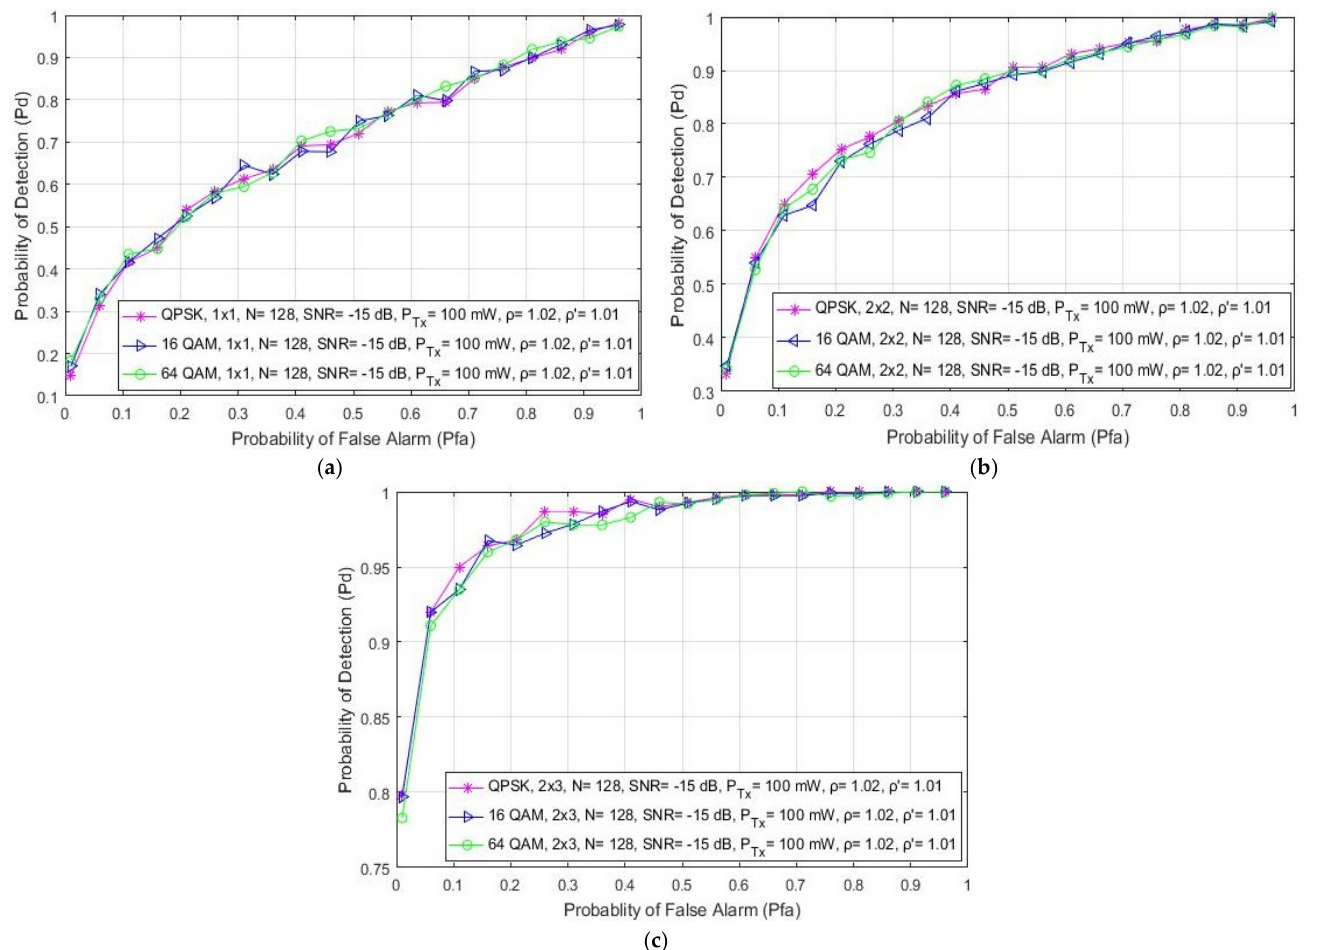
Figure 6. The ROC curves presenting the ED performance for signal transmission with different modulation schemas in ( a ) SISO, ( b ) symmetric MIMO (2 × 2) and ( c ) asymmetric MIMO (2 × 3) systems.